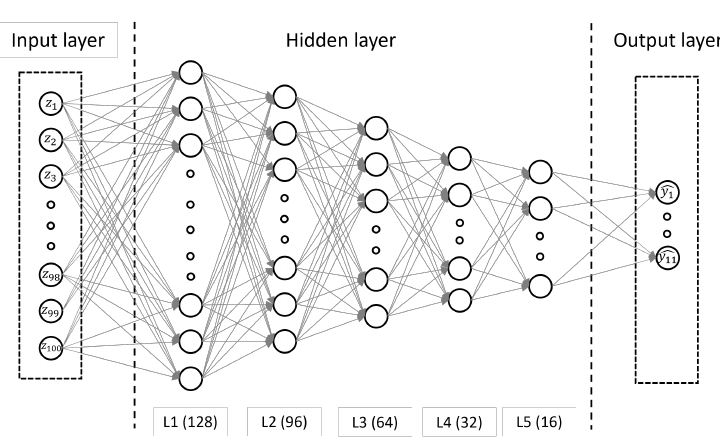
Figure 2. The architecture of the attack detection